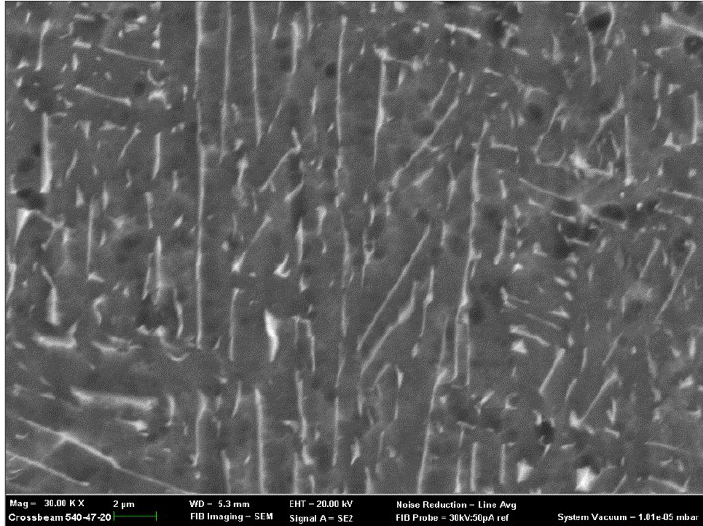
Figure 11. Scanning electron microscopy (SEM) micrograph taken on specimen A cross section.